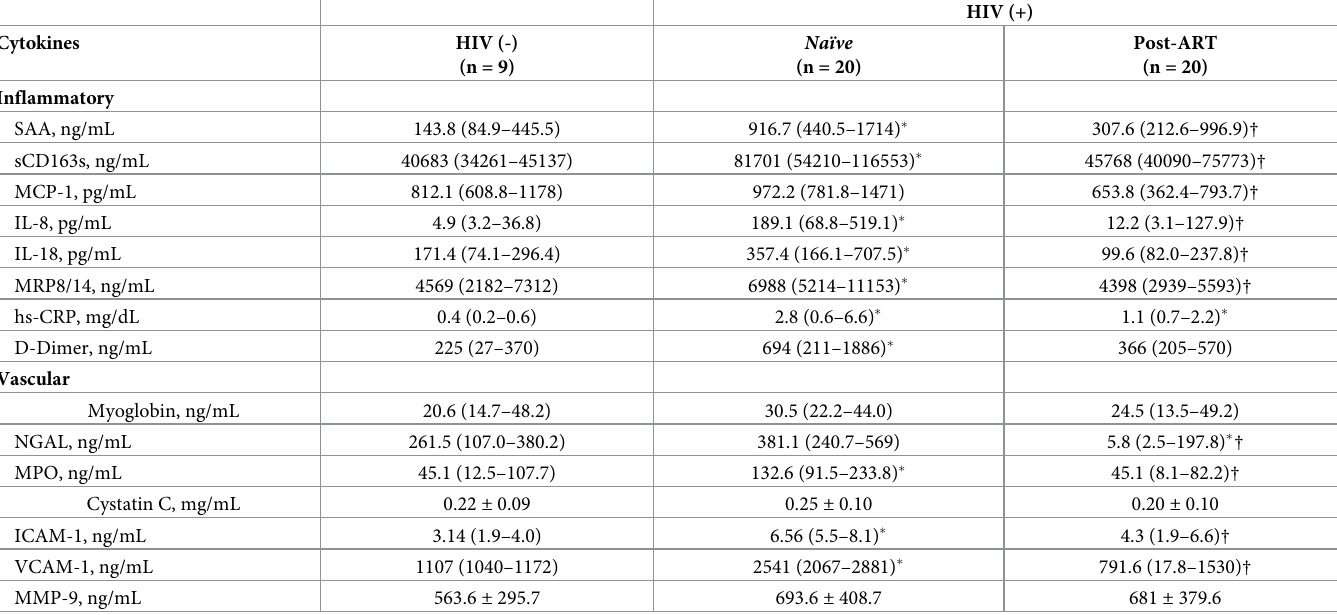
Table 2. Inflammatory, vascular, and metabolic cytokines in controls, HIV+ naïve and HIV+